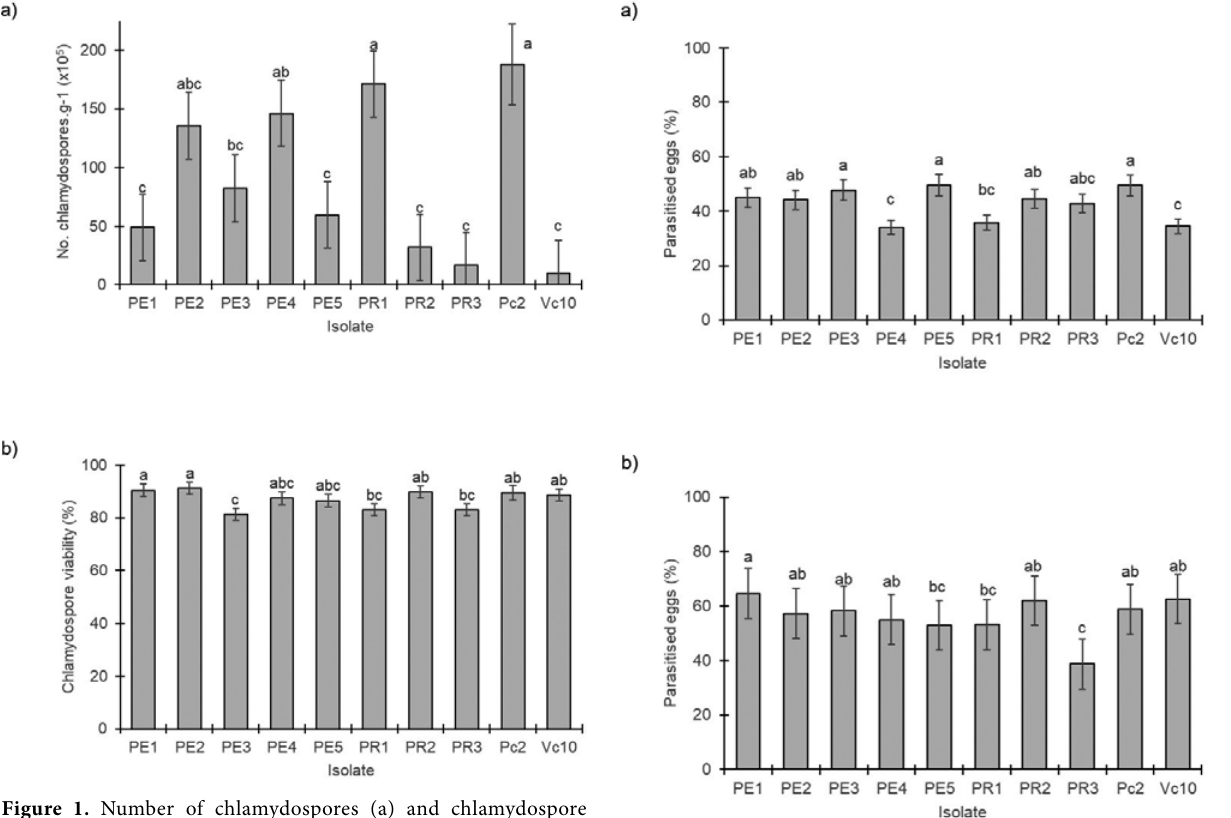
Figure 1. Number of chlamydospores (a) and chlamydospore viability (b) of ten Pochonia chlamydosporia isolates (PE1, PE2, PE3, PE4, PE5, PR1, PR2, PR3, Pc2 and Vc10) grown for 30 d on barley:sand substrate (1:1) (refer to Table 1 for isolate information). Bars represent standard errors of means. Columns accompanied by the same letter are not significantly, different (LSD test; P < 0.05).